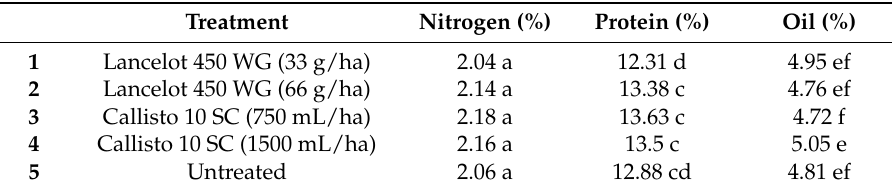
Table 7. Effects of the treatments on seed quality